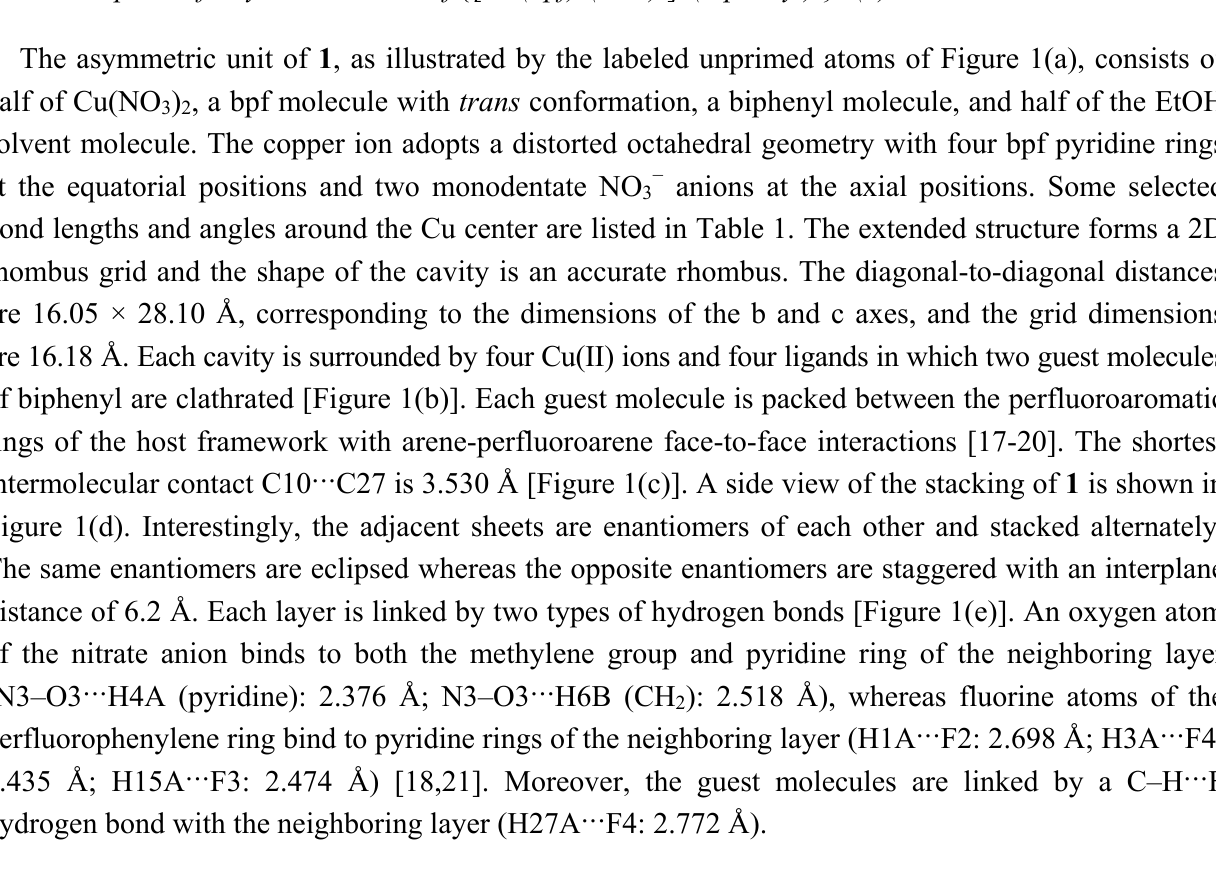
Figure 1. Crystal structure of 1 . (a) ORTEP view around the metal center. Thermal ellipsoids are shown at 50% probability. (b) Top view of the 2D sheet structure. Hydrogen atoms, solvent EtOH molecules and nitrate anions are omitted for clarity. (c) Top view of the cyclic cavity with guest molecules linked by arene-perfluoroarene face-to-face interactions. (d) Side view of the stacking layers linked by hydrogen bonds. (e) Side view of the stacking layers linked by hydrogen